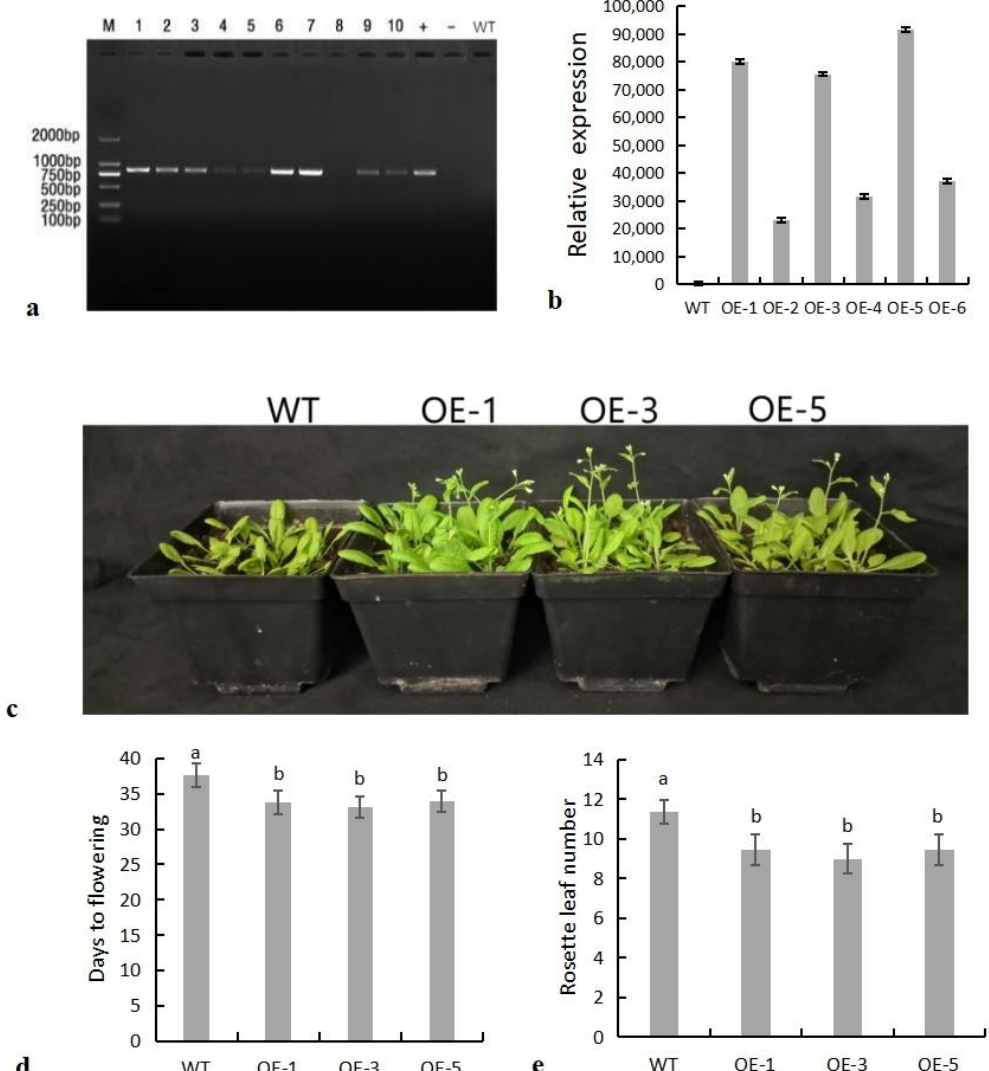
Figure 5. SiNF-YC2 positively regulates flowering time. ( a ) PCR detection of transgenic Arabidopsis (M: 2 kb DNA marker; +: positive control; − : negative control; WT: wild-type Arabidopsis; 1–10: transgenic Arabidopsis OE-1 to OE-10). ( b ) Quantitative screening of SiNF-YC2 . ( c ) Flowering phenotypes of wild-type and transgenic Arabidopsis. ( d ) Flowering time statistics. ( e ) Rosette leaf phenotypes of wild-type and transgenic Arabidopsis. Different letters on columns indicate significant differences at the level of 0.05. p < 0.05 indicates significant differences between statistical data, p > 0.05 indicates insignificant differences between statistical data, and p < 0.01 indicates extremely significant differences between statistical data. Different lowercase letters indicate differences between different strains.